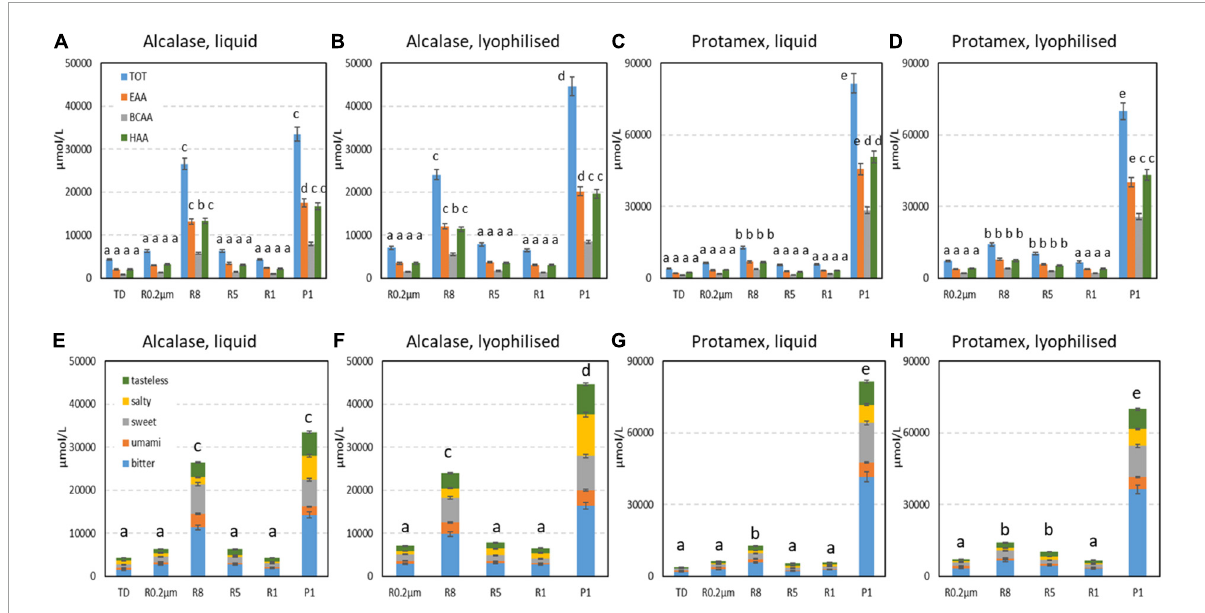
FIGURE3 Elaboration of free amino acid contents in total digestate (TD condition 5) and peptide fraction samples from (A,B,E,F) Alcalase to (C,D,G,H) Protamex treatments, in liquid and lyophilized forms. (A–D) Predicted nutritional/structural characteristics and (E–H) taste property contributions were quantified in µ mol/L, by elaboration of data reported in Supplementary Table 1 . TOT, total amino acid content; EAA, total essential amino acid; BCAA, total branched-chain amino acid; HAA, total hydrophobic amino acid. Data represent the mean ± SD ( n = 3). Different letters indicate a statistically significant difference (one-way ANOVA test followed by post hoc corrected two-tailed Tukey test, p < 0.05) between the same type of data ( A–D : TOT, EAA, BCAA, HAA; E–H : total levels), from the lowest (a) to the highest (e).